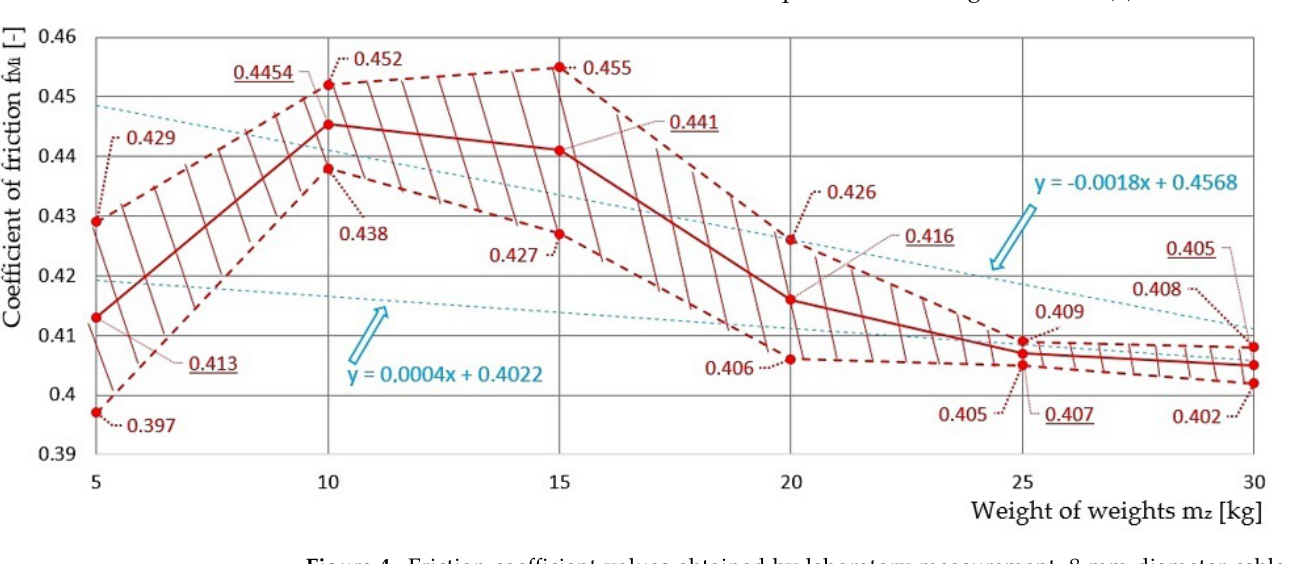
Figure 4. Friction coefficient values obtained by laboratory measurement, 8 mm diameter cable, groove surface contaminated with oil.